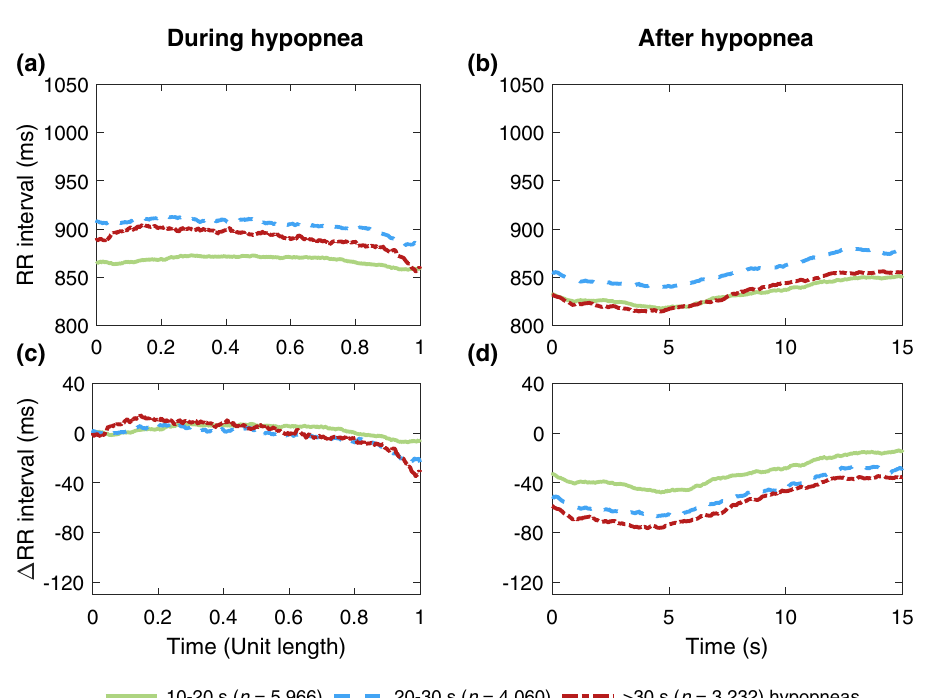
Figure 4. Median RR intervals of women ( n = 359) ( a) during hypopneas of different durations ( n = 13 258) and ( b) during a 15-s segment following hypopneas. The absolute change in RR intervals relative to the beginning of the event during and after hypopneas are presented in subfigures ( c) and ( d) , respectively. In subfigures ( a) and ( c) the duration of every hypopnea event is normalized with its